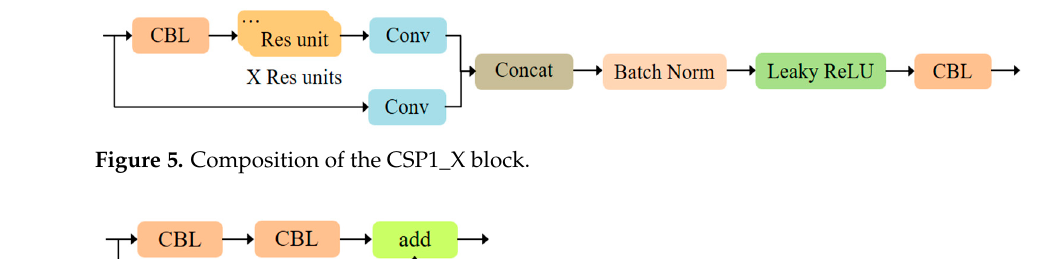
Figure 4. Composition of the CBL block .